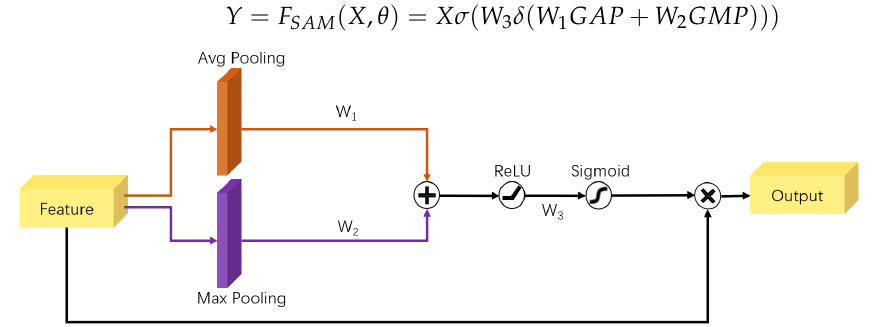
Figure 6. The structure of Spatial Attention Module.